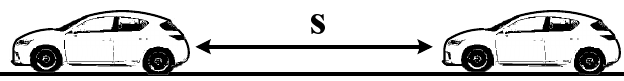
Figure 2. Distance from the front to